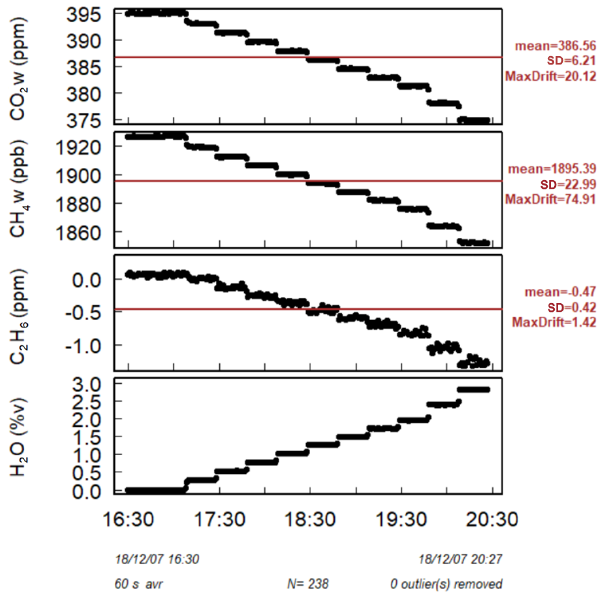
Figure A1. H 2 O influence on CO 2 , CH 4 and C 2 H 6